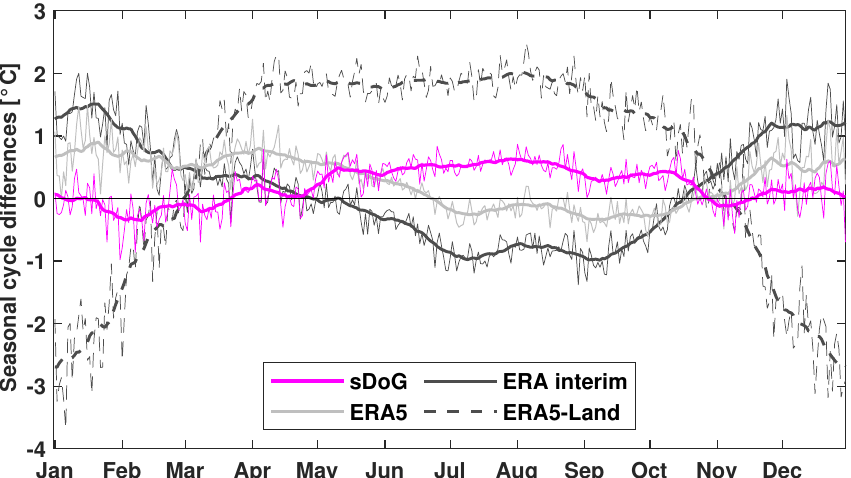
Figure 9. Differences between the mean seasonal cycles of sDoG (magenta), ERA-Interim (dark grey), ERA5 (light grey) and ERA5-Land (grey dashed) to VERNAGT air temperature in the true evaluation period(1979-2001) (obs-trueval). Shown are the differences of the mean values calculated for each day of year (thin lines), and of moving averages centered on each day of year with a window size of 20 days (solid